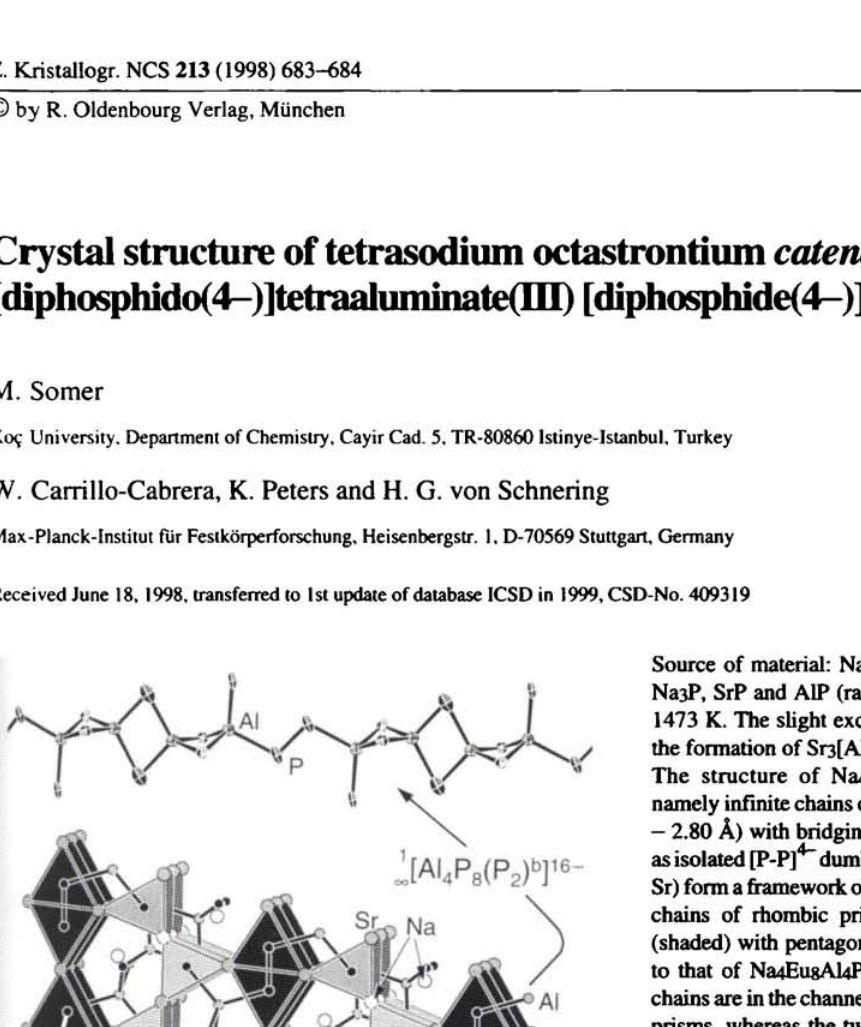
Table 1. Parameters used for the X-ray data collection Crystal: